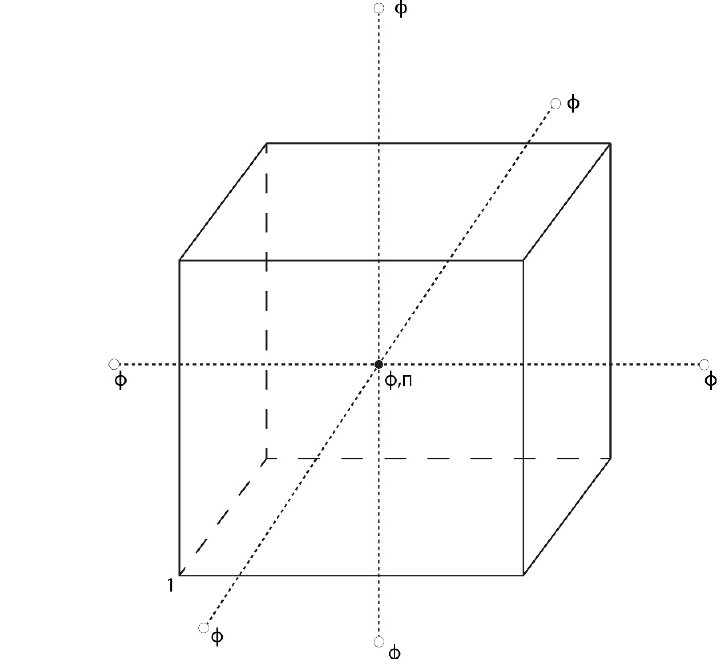
Figure 2 . An illustration of Kramers-Wannier duality. The two-form (cid:12)elds live on the faces of the box, and the scalar (cid:12)eld lives on the vertices of the dotted lattice. The dual vertices outside the original box, whose (cid:30) variables generate large gauge transformation, don’t have a (cid:25)